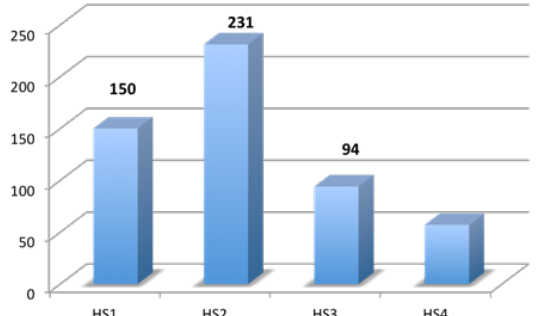
Figure 1. Number of emergency department clinicians reporting on patients with information in the health information exchange by hospital system (HS). HS1 is academic hospital. Others are community hospitals.